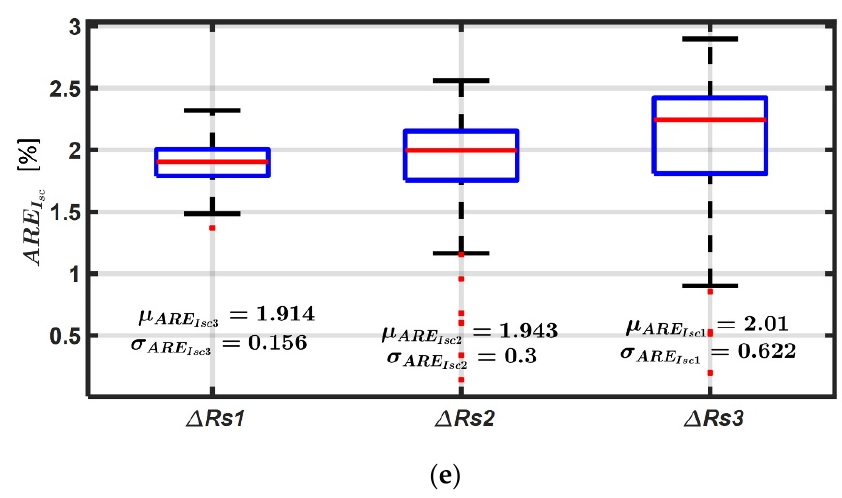
Figure 26. Effect of series resistance R s faults on the I–V curve characteristics. ( a ): Fault effect on PV module’s current; ( b ): Fault effect on PV module’s voltage; ( c ): Fault effect on maximum power; ( d ): Fault effect on open-circuit voltage; ( e ): Fault effect on short-circuit current.